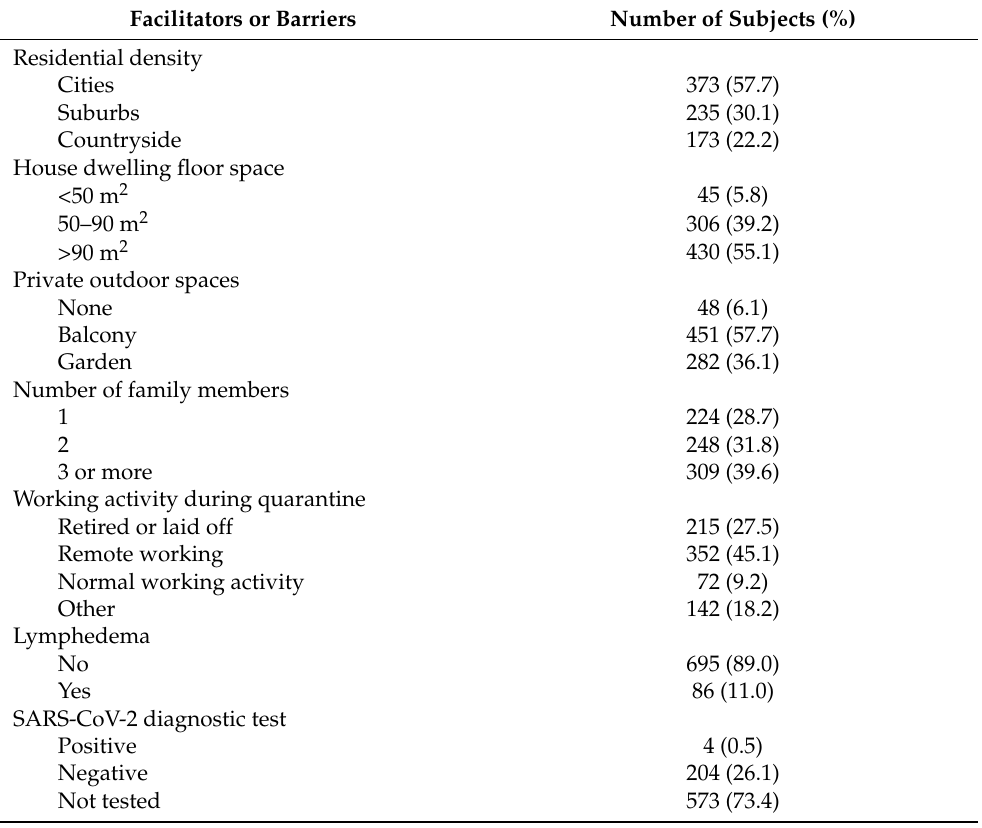
Table 2. Facilitators or barriers to physical activity in subjects included in the surveillance